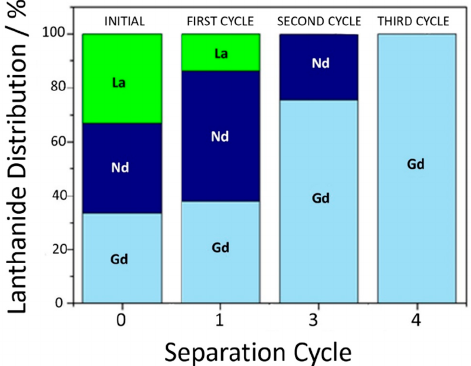
Figure 23. Fractionation of a ternary mixture, starting from equimolar amounts (stage 0) of Gd 3+ , Nd 3+ and La 3+ ions, by using superparamagnetic nanoparticles functionalized with DTPA (adapted with permission from [44]).